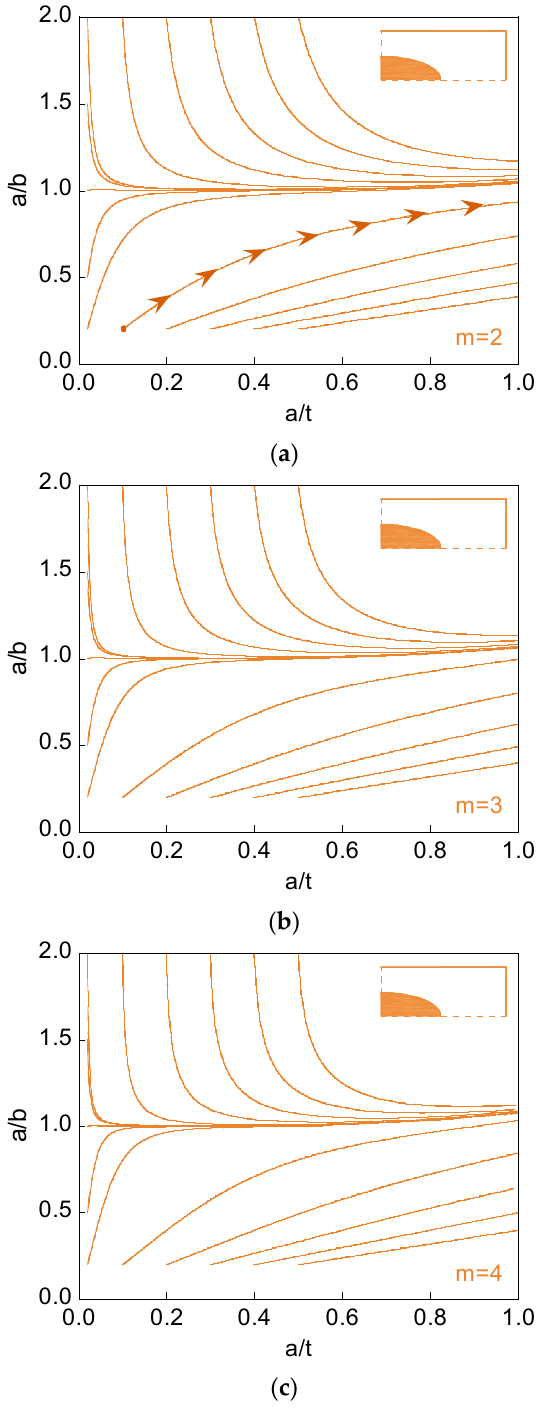
Figure 3. Aspect ratio evolution with relative crack depth (propagation path) for embedded cracks: ( a ) m = 2; ( b ) m = 3; ( c ) m = 4.